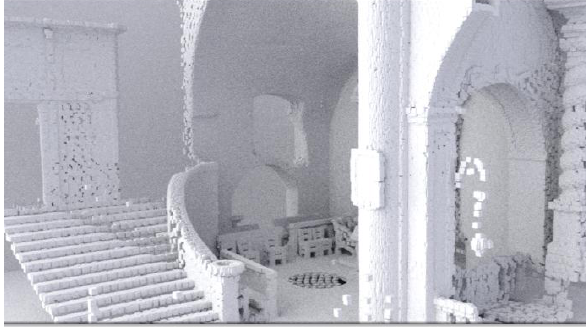
Figure 9. 3D model obtained using the particle system strategy in